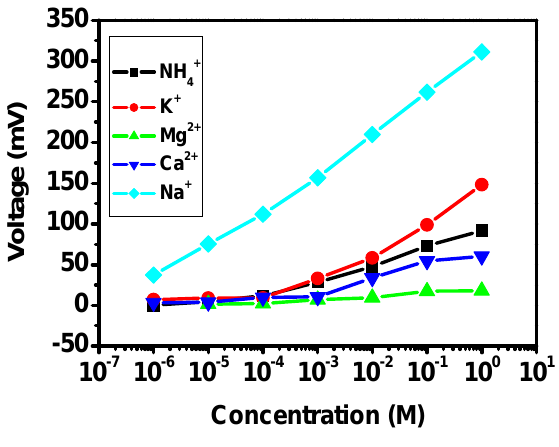
Figure 9. Interference study by Separate Solution Method for sodium ion selective electrode.